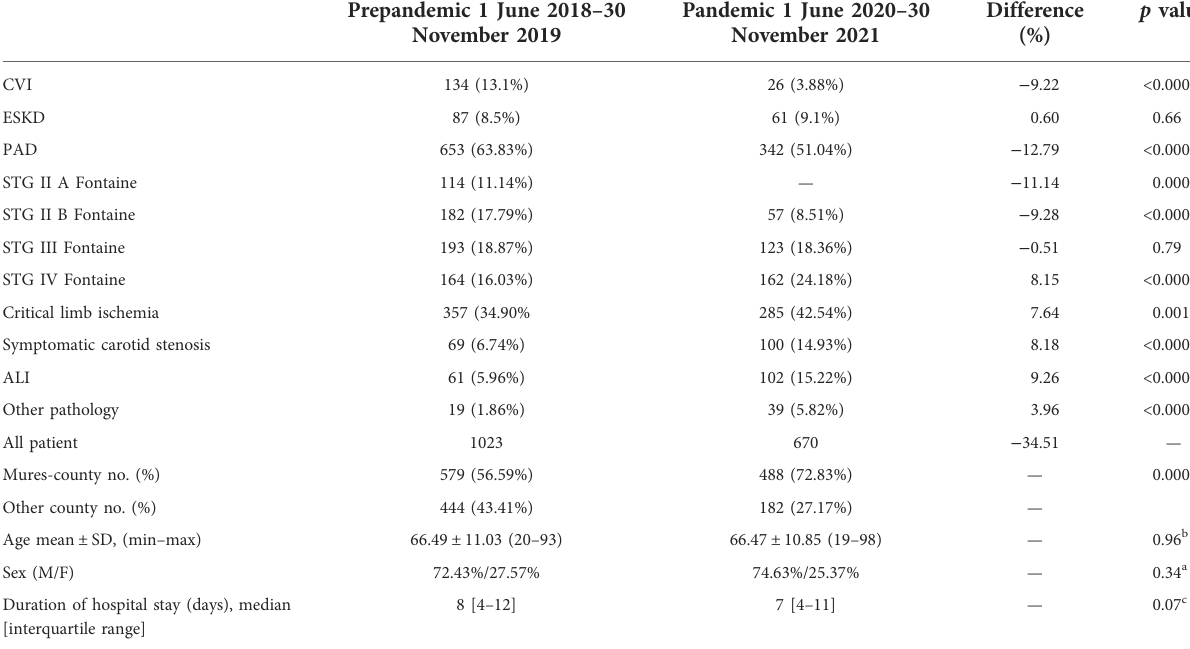
TABLE 1 Pathologies and basic characteristics for the prepandemic and the pandemic